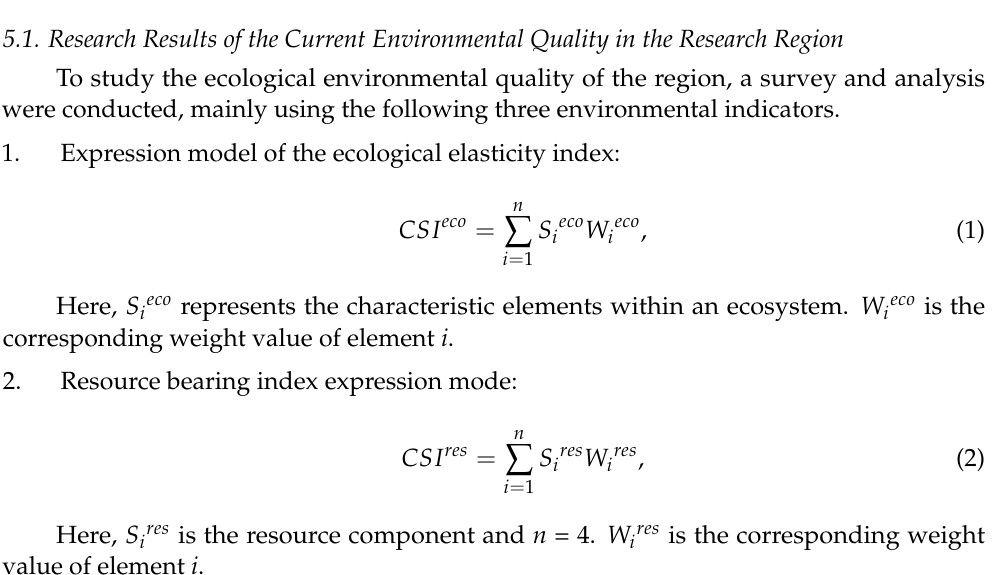
Figure 2. Distribution of groundwater resources in the Qian’an region.